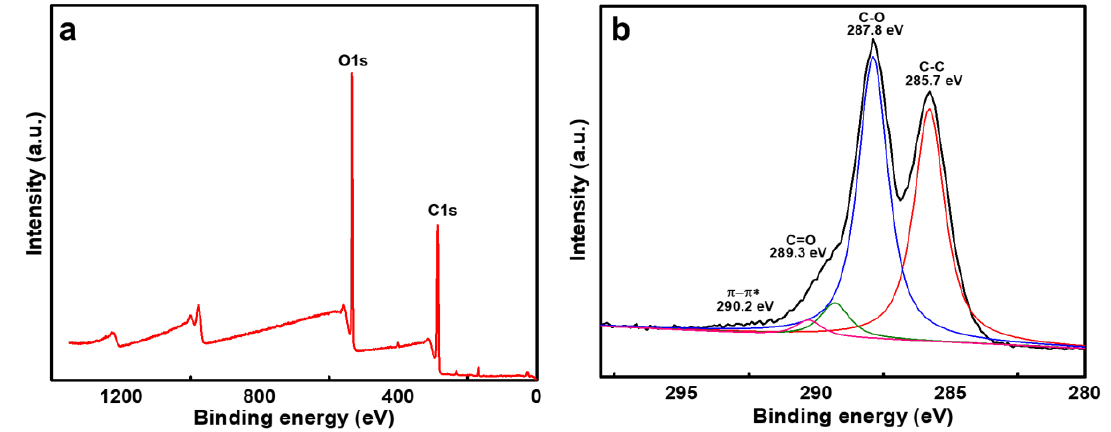
Figure 3. ( a ) full scan and ( b ) detailed C1s scan of GO using X-ray photoelectron spectroscopy.